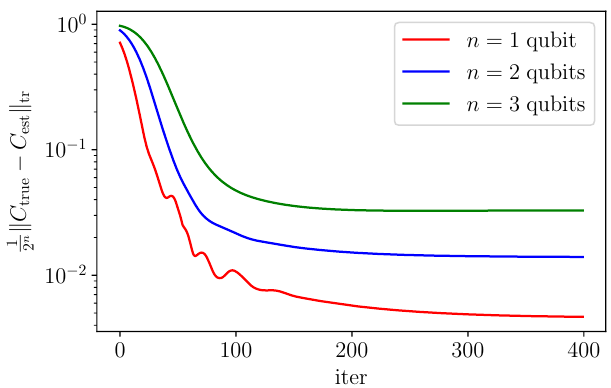
Figure 7: Dependence between Jamiołkowski process distance and number of itera- tion. Number of measurement outcomes N = 600000 for all